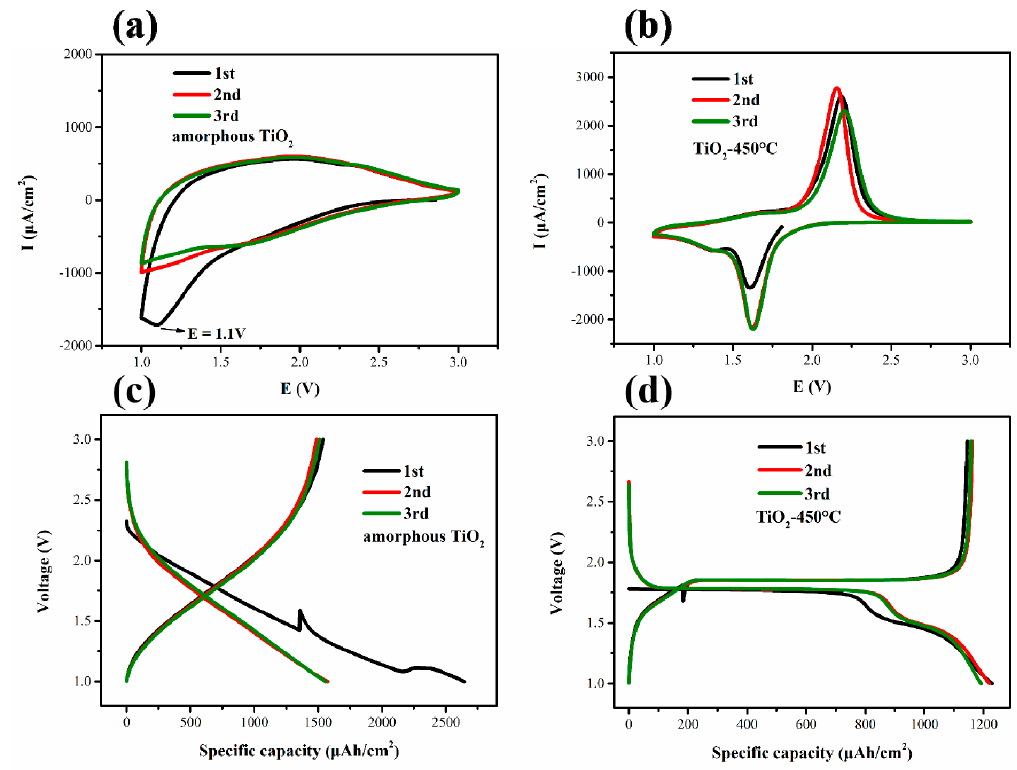
Figure 8. CV curves of amorphous TiO 2 -20 h ( a ) and anatase TiO 2 -20 h-450 °C ( b ) at a sweep rate of 0.2 mV/s. The first three cycles charge/discharge curves of amorphous ( c ) and anatase ( d ) TiO 2 nanotubes. The voltage range was between 1.0 and 3.0 V, and the constant charge and discharge current was 100 µ A/cm 2 . The samples were synthesized in electrolyte with 0.5 wt% NH 4 F and anodization time of 20 h.